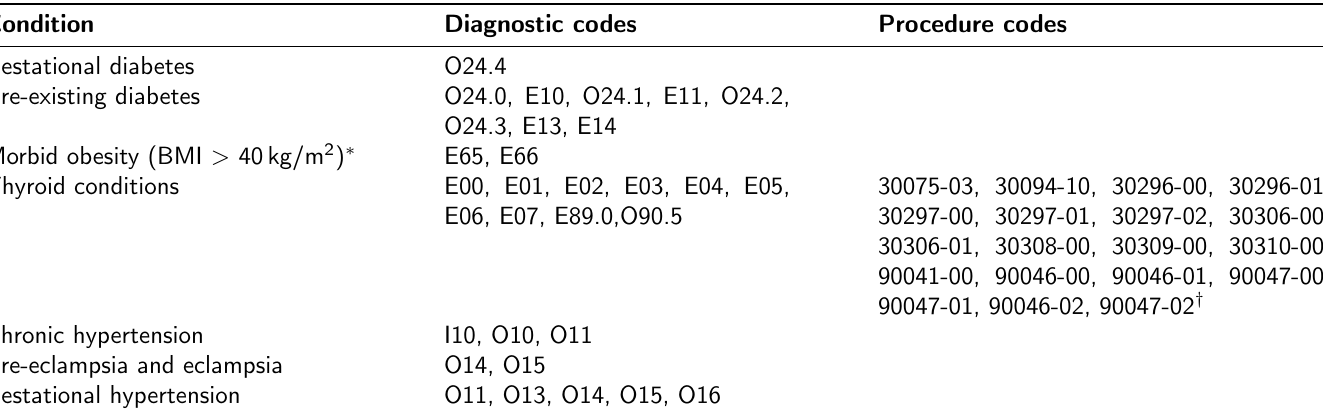
Supplementary Table 1: ICD-10-AM diagnostic and ACHI 8 th Edition procedure codes used to ascertain presence of conditions in